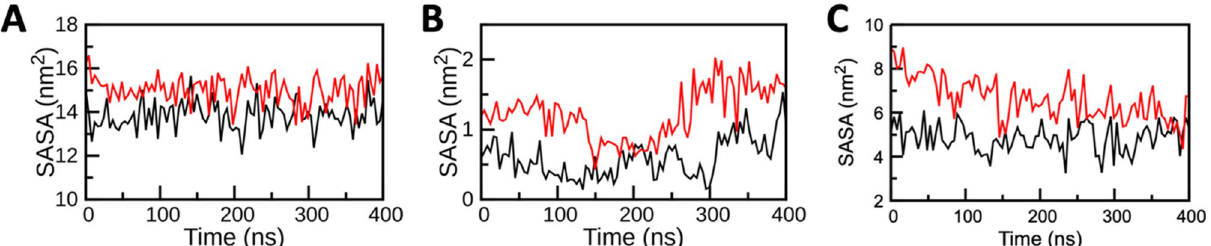
Figure 3. Solvent accessible surface area (SASA) analysis of key residues of ACE2, TMPRSS2, and RdRP during 400 ns MD simulations; ( A ) SASA of ACE2 ( B )SASA of TMPRSS2and (C) SASA of RdRP. SASA of the complex and apo are displayed by black and red curves, respectively. For ACE2 residues 22 24, 27, 28, 30, 31, 34, 35, 37, 38, 41, 42, 79, 82, 83, 330, 353, 354, 355, 357, 393, for TMPRSS2 residues 20,21 296, 345, 435, 441 and for RdRP residues 20,21 545, 553, 555, 557, 618, 623, 680, 682, 691, 760, 761 were included for this analysis.